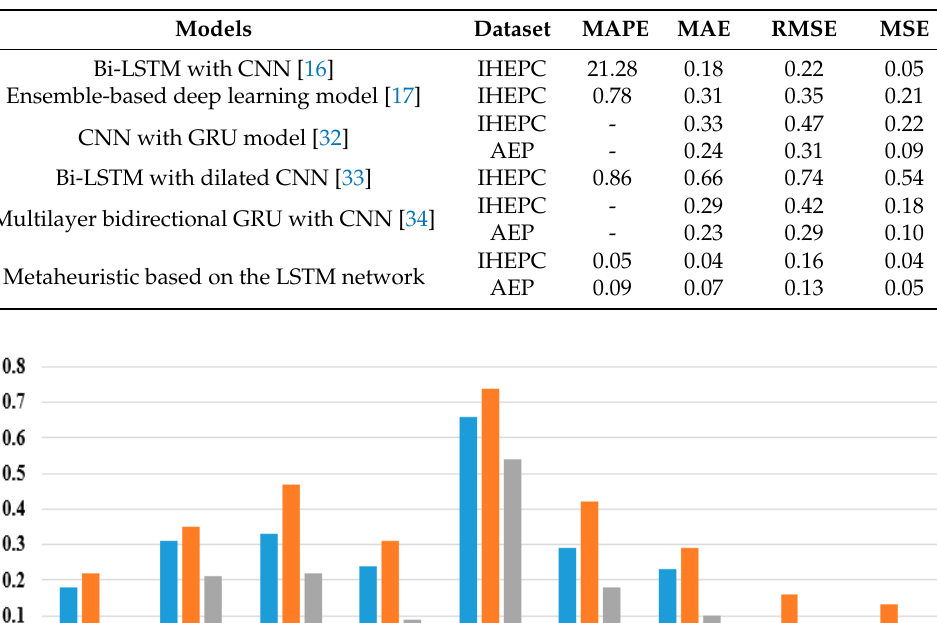
Table 7. Statistical comparison of the proposed model with the existing models for the AEP and IHEPC datasets.